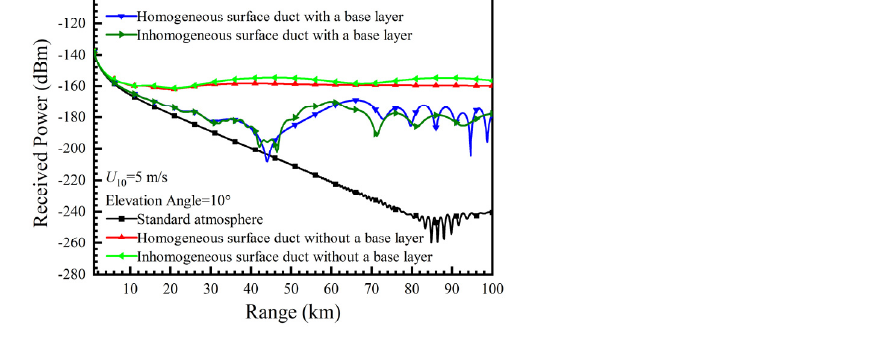
Figure 7. Received powers versus the horizontal distance in standard atmosphere, horizontally